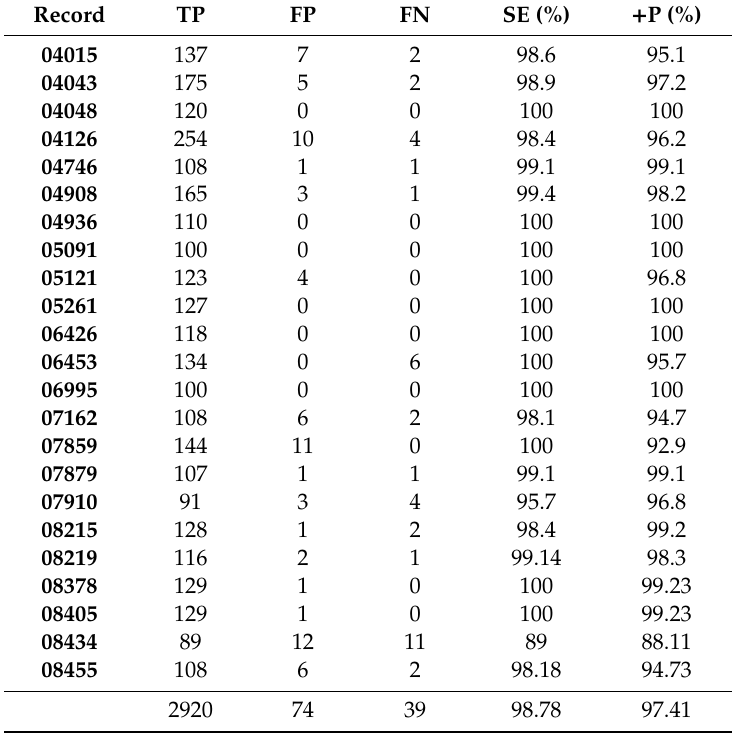
Table 2. P-wave detection performance over the annotated MIT-BIH Atrial Fibrillation